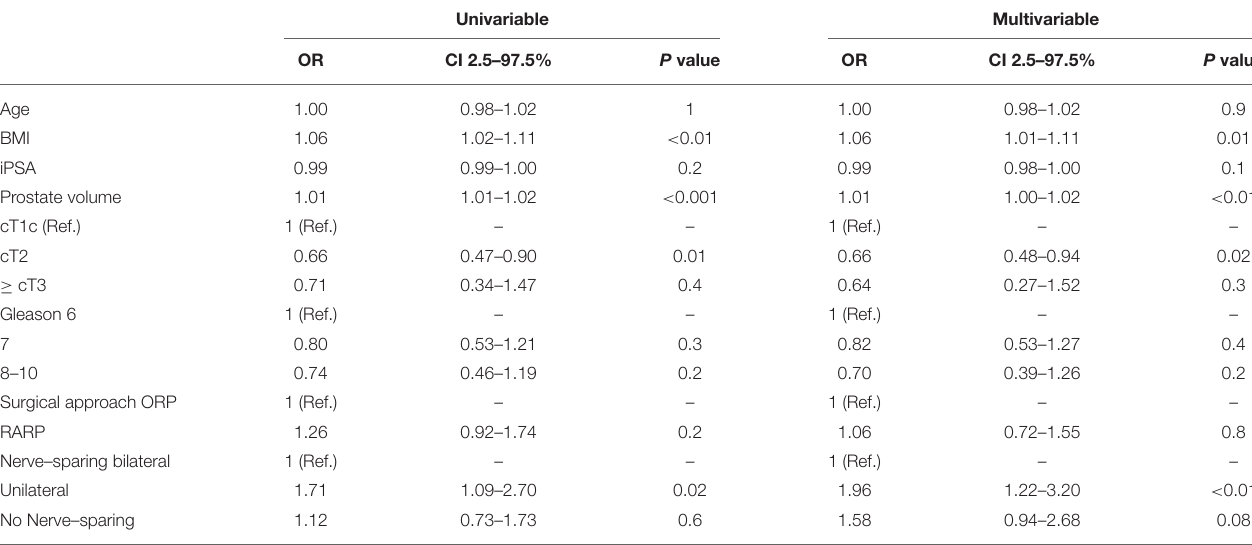
TABLE 4 | Univariable and multivariable logistic regression models predicting OR time > 233min